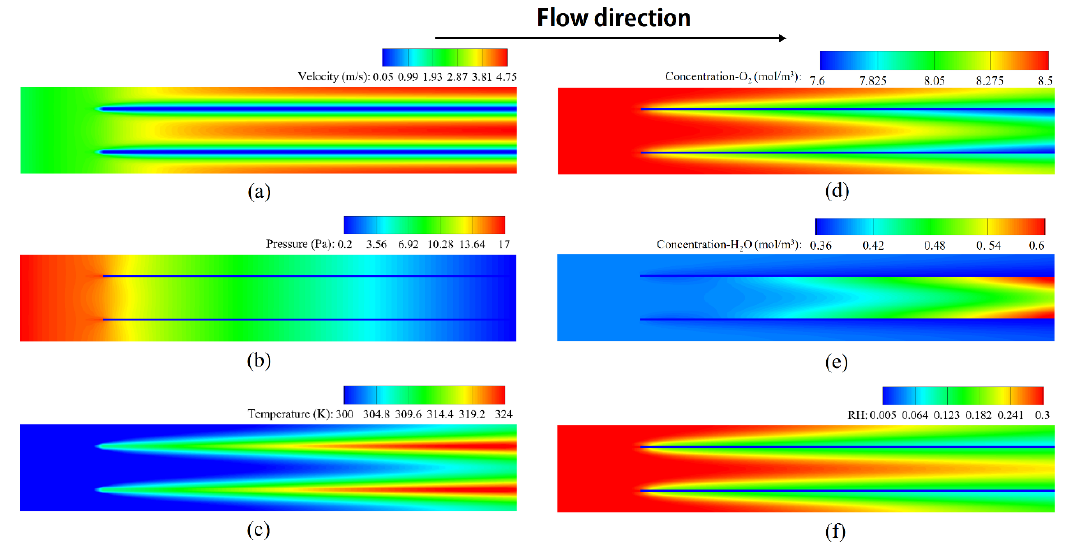
Figure 4. Key variable distribution in the middle plane of cathode flow field for Case 1 design: ( a ) pressure, ( b ) velocity, ( c ) temperature, ( d ) oxygen concentration, ( e ) water vapor concentration and ( f ) relative humidity distribution.